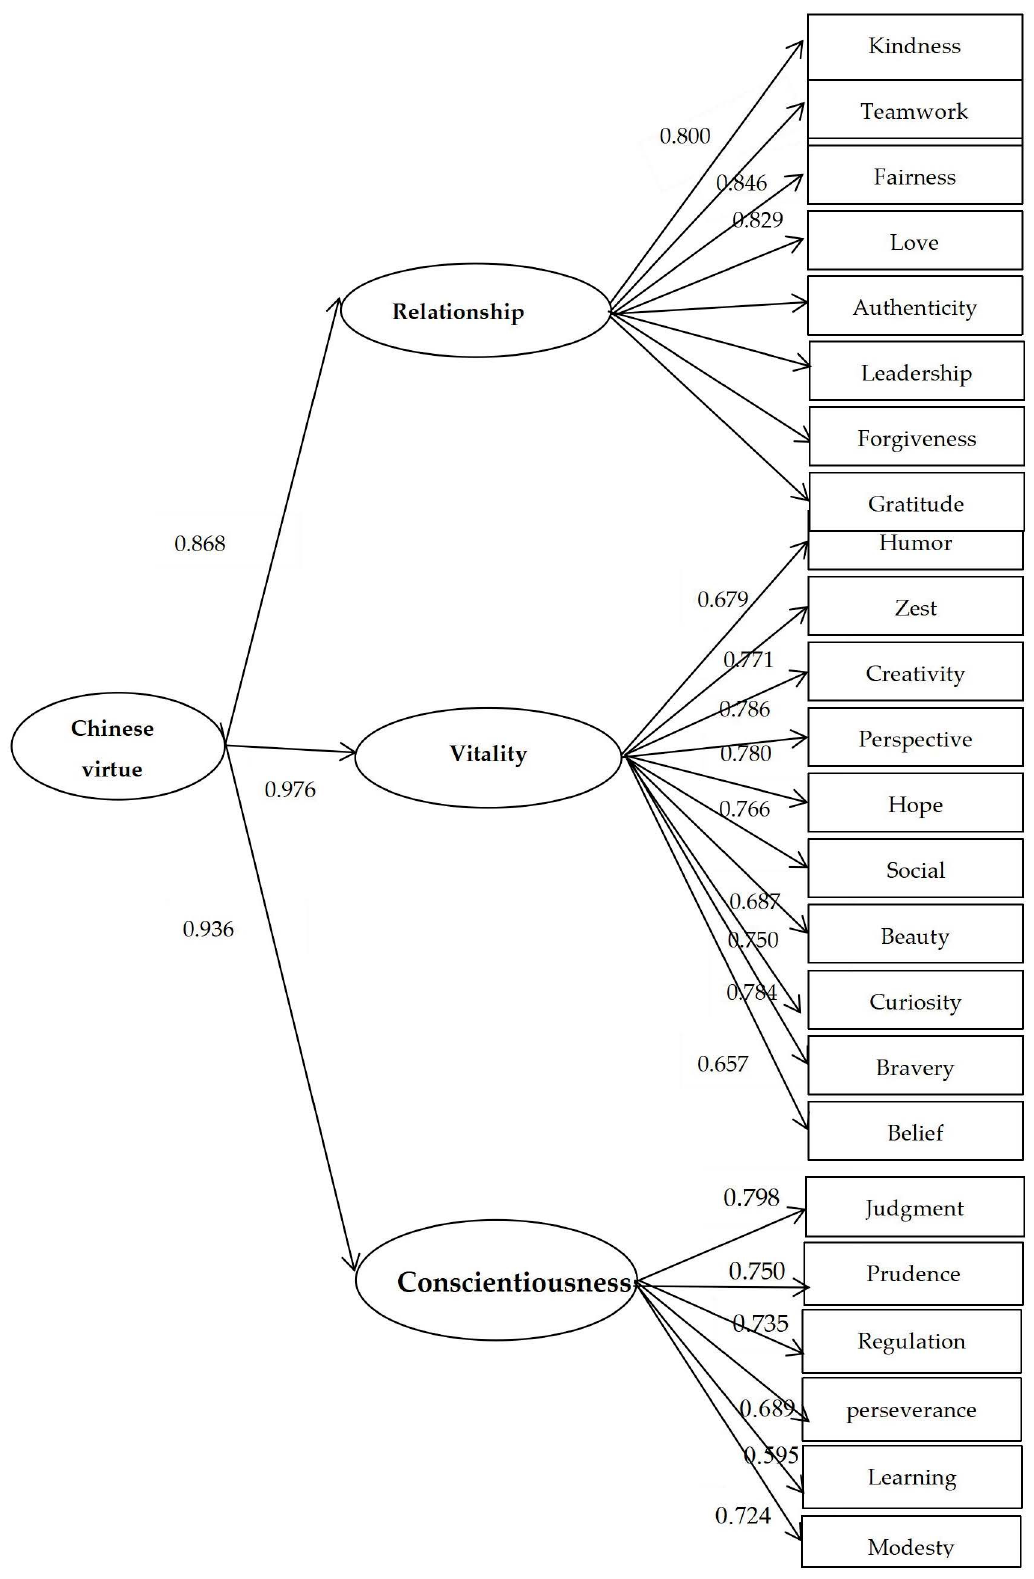
Figure 1. Measurement Model for Chinese Virtues.